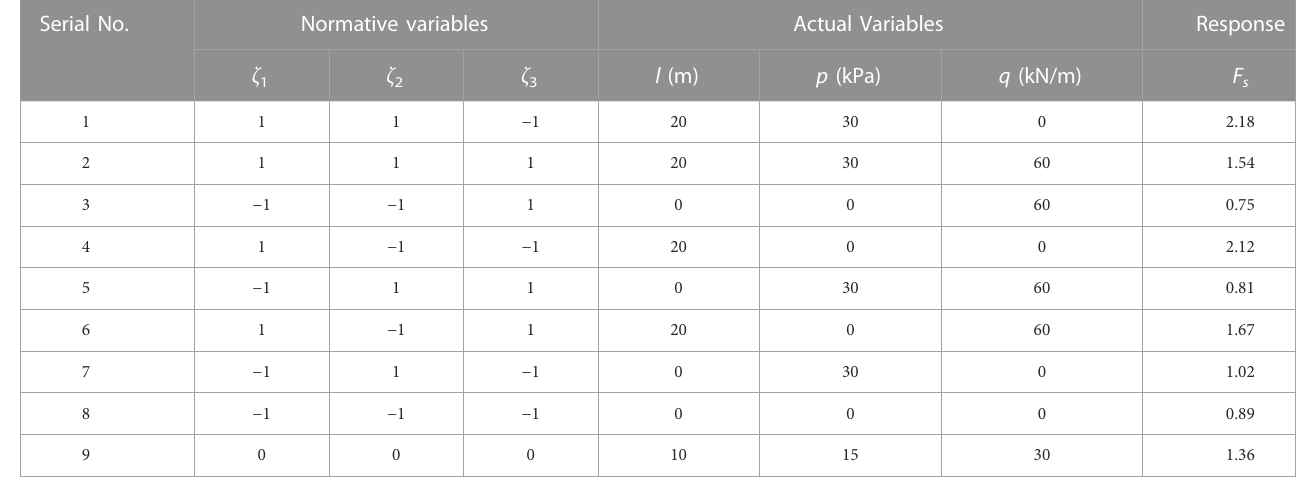
TABLE 3 Response of experimental design and stability factor of safety in the initial region U 1 . Serial